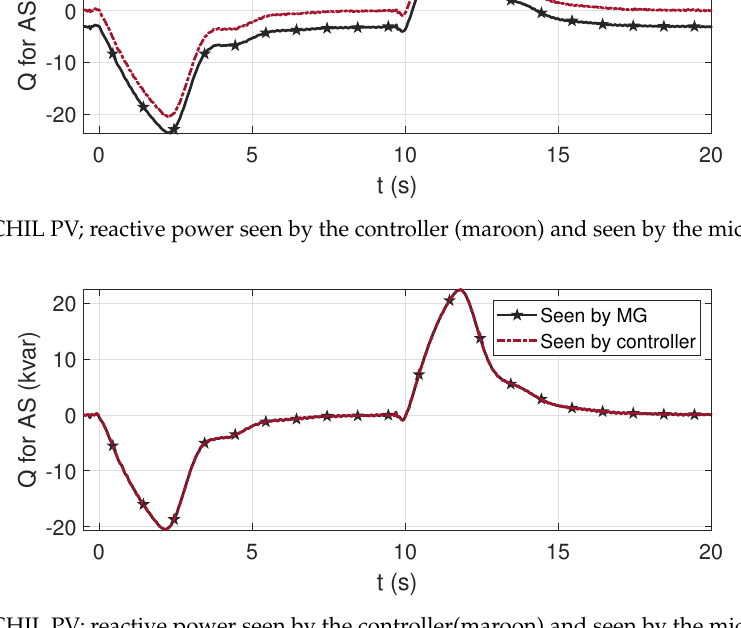
Figure 15. CHIL PV; reactive power seen by the controller(maroon) and seen by the micro grid (black) after compensation of the measurement